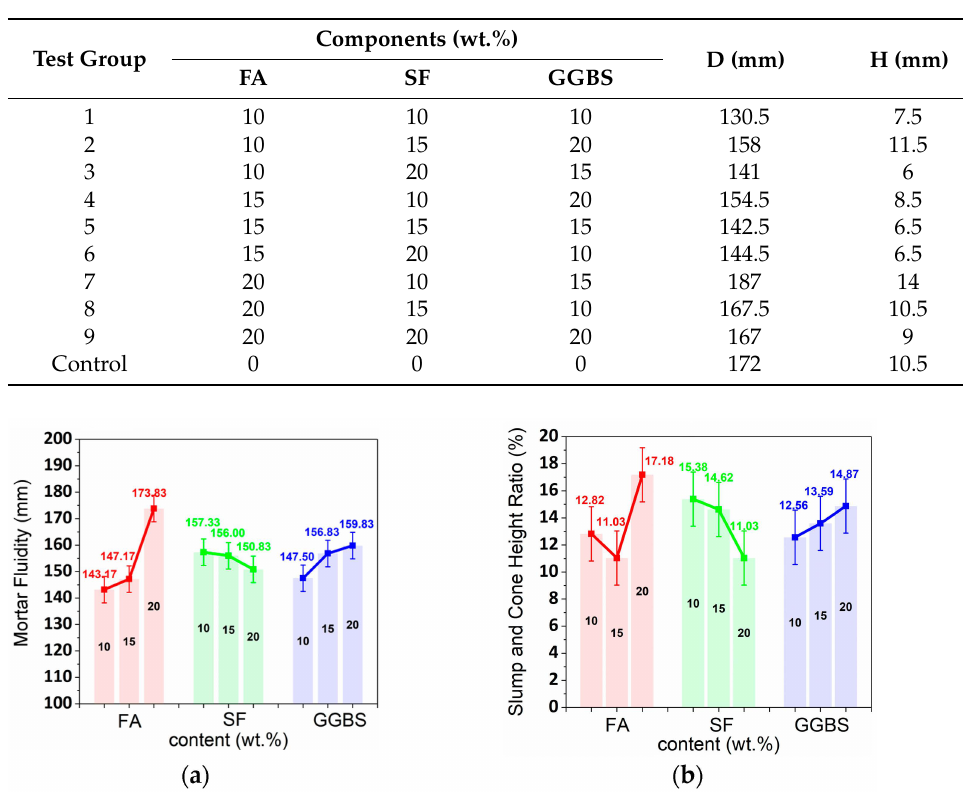
Figure 9. The average values of ( a ) fluidity and ( b ) slump cone height ratio with the various content (10%, 15%, and 20%) of FA, SF, GGBS,